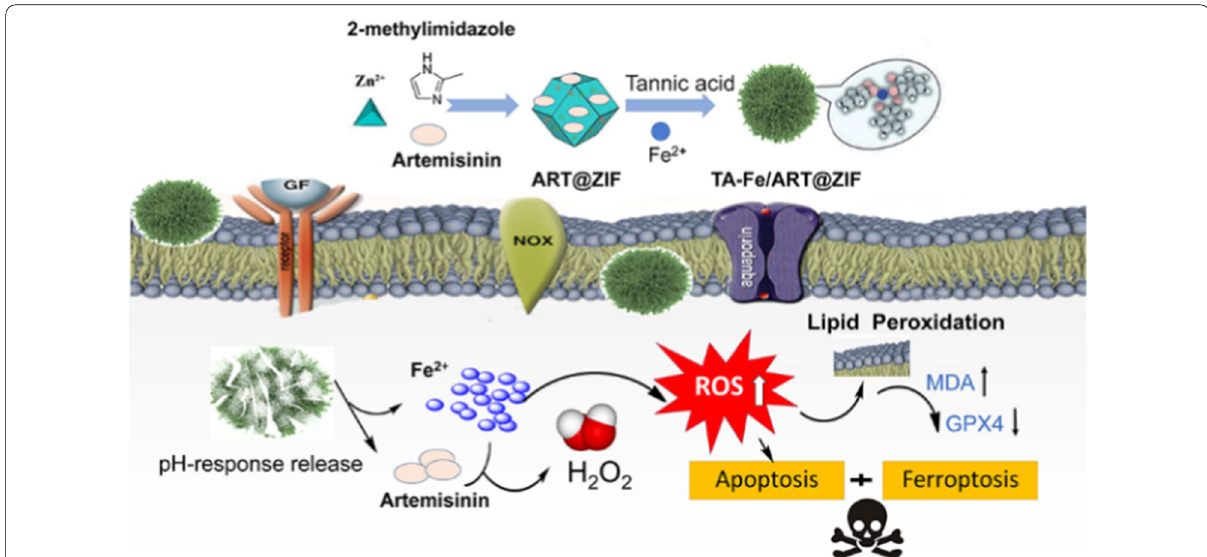
Fig. 1 Schematic representation of preparation of TA-Fe/ART@ZIF nanoparticles and the synergistic induction of apoptosis/ferroptosis in tumor